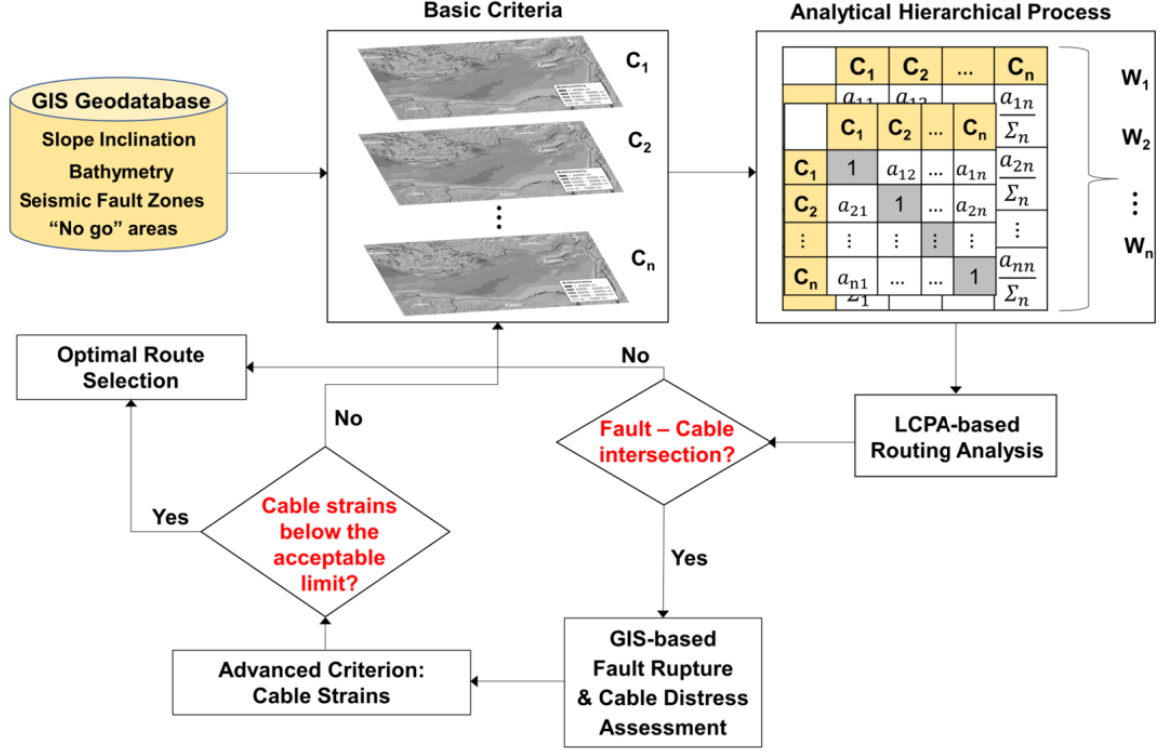
Figure 1. Flowchart of the developed smart decision-support tool.